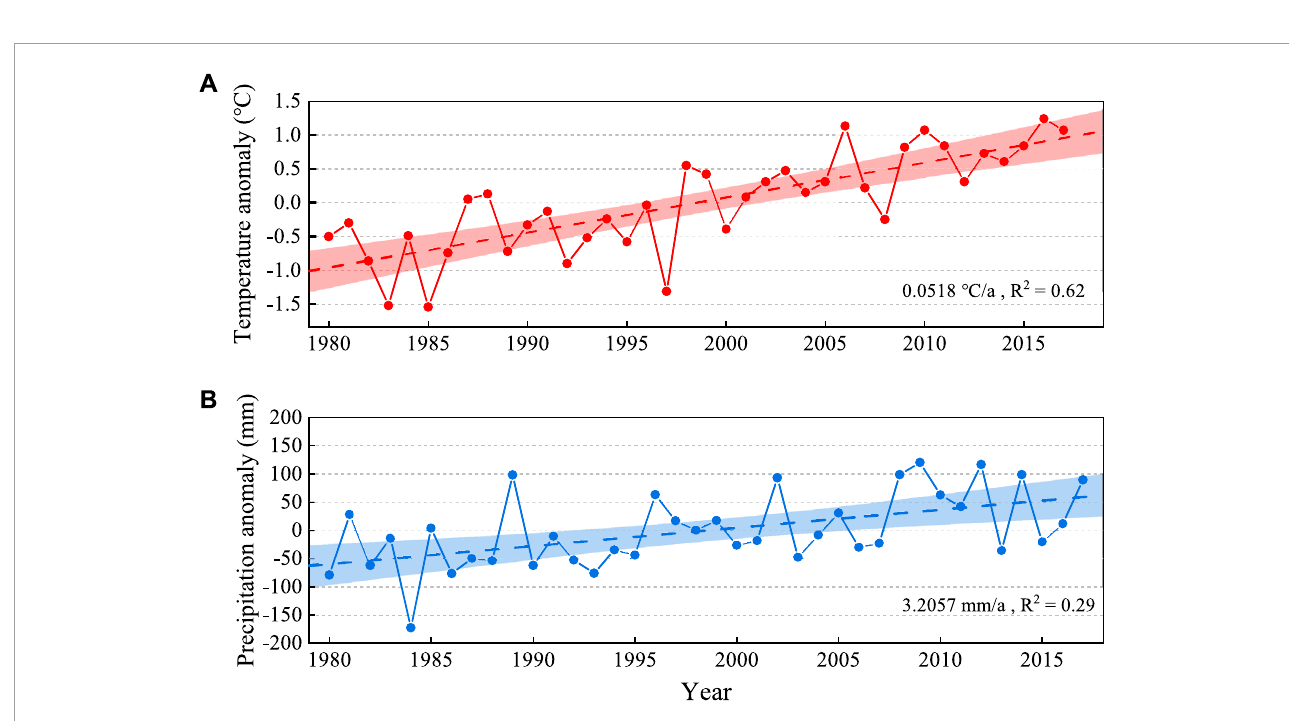
FIGURE 8 Climate variations from 1980 to 2017: (A) time series of annual average temperature change and (B) time series of annual precipitation